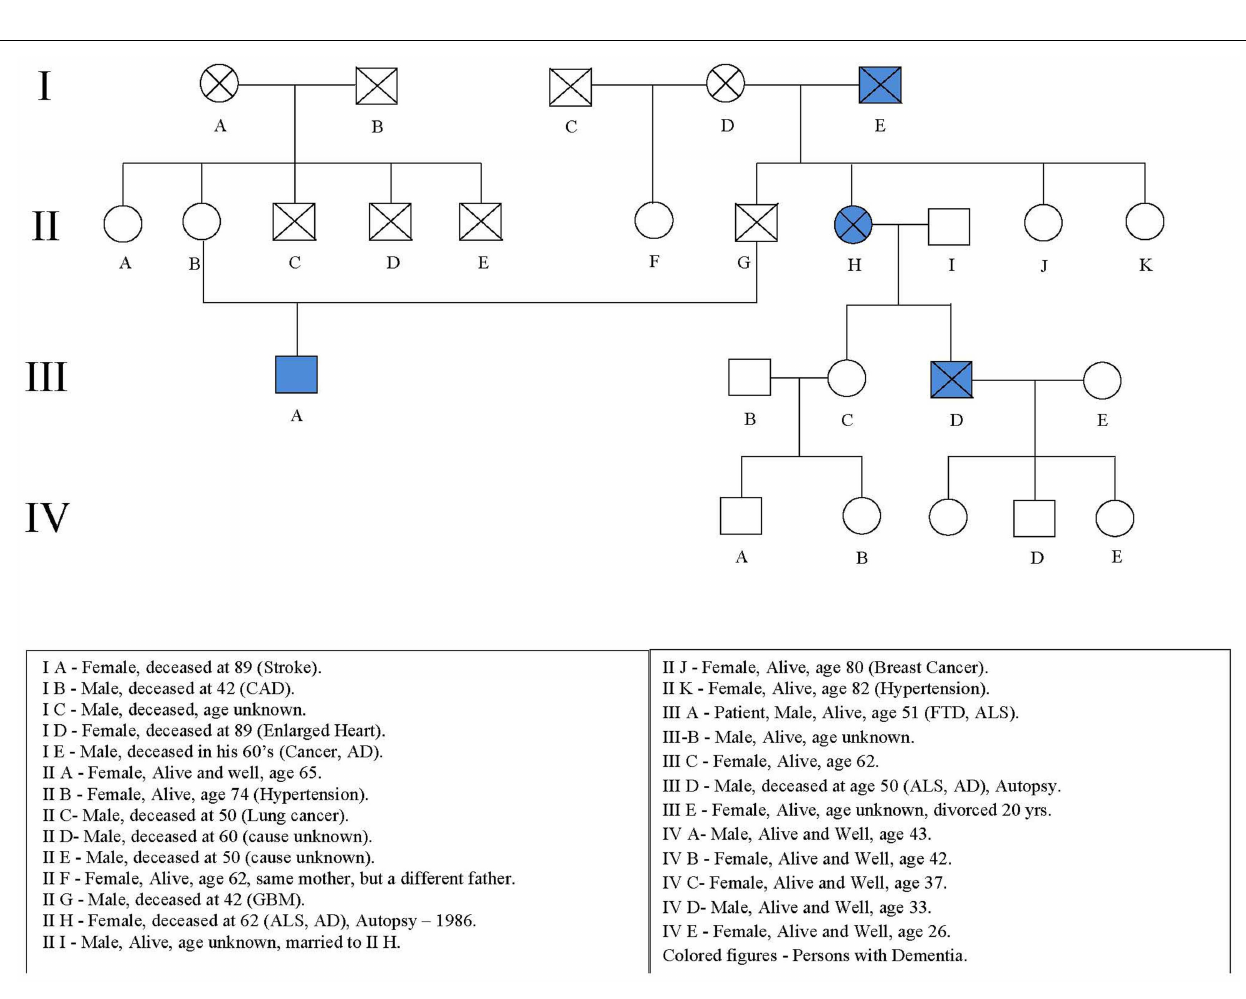
FIGURE 1 | Pedigree. The proband is subject